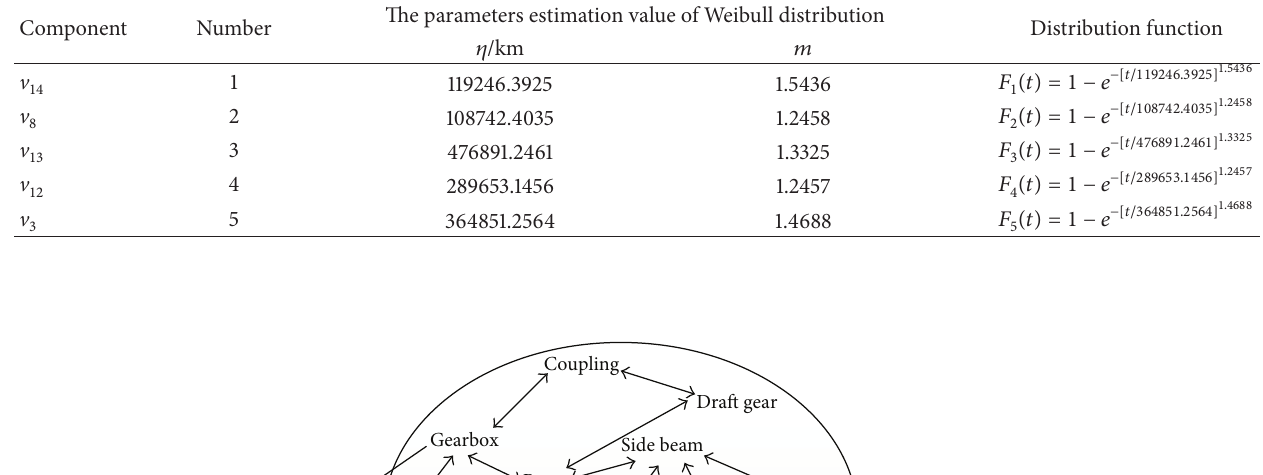
Table 3: The maximum likelihood estimation of main components in bogie subsystem.